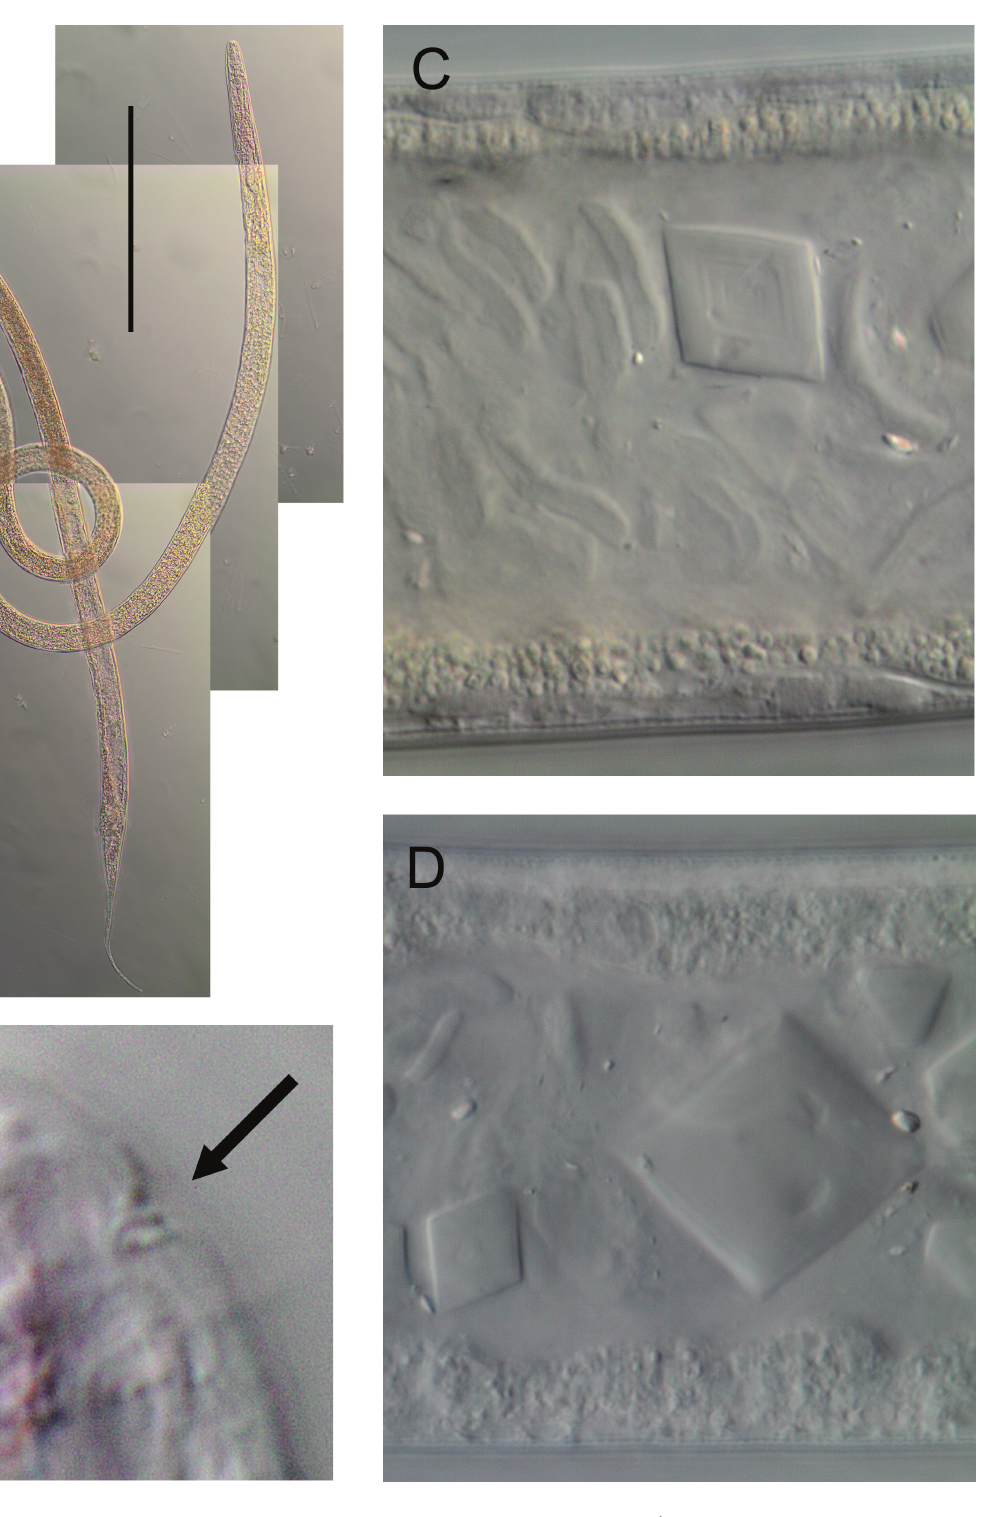
Fig. 3. Thelonema clarki sp. nov. Light micrographs. A . Holotype, ♂, entire biody. B . cross-section view of sunken papilla, second circle of cephalic sensillae. C . Female gut content, showing crystalline structures and other unidentified contents. D . Juvenile gut showing crystalline structures. Arrow shows position of sunken papilla of third circle of cephalic sensillae. Scale bar: A = 520 µm; B = 5 µm; c–D = 20